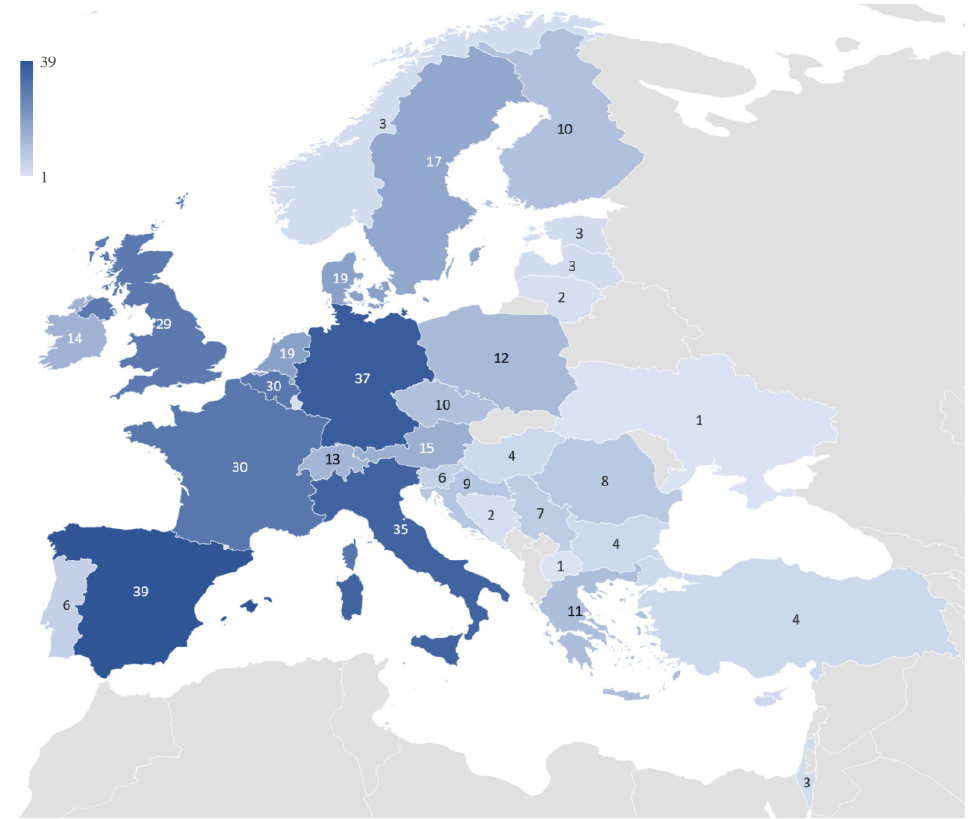
Figure 3. Number of projects per participating country. In addition, India participates in one project (not shown).